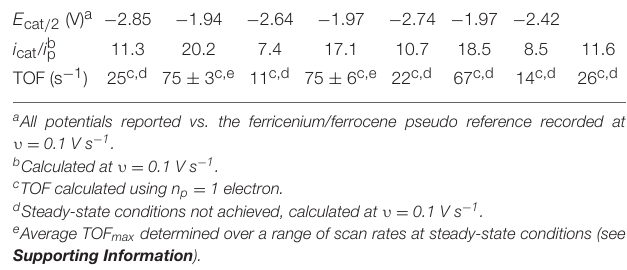
Table 3 . Pre-catalysts [1-CH 3 CN] + and [2-CH 3 CN] +